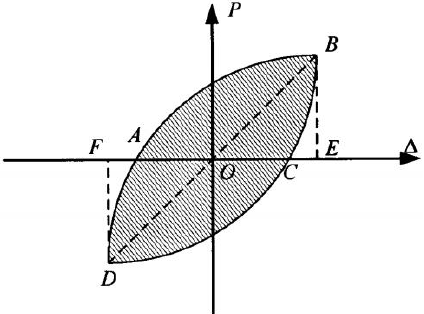
Figure 24. Schematic calculation for equivalent viscous damping coefficient. Based on Figure 24 and Equation (7), the equivalent viscous damping coefficient- displacement curves of all specimens are plotted in Figure 25.